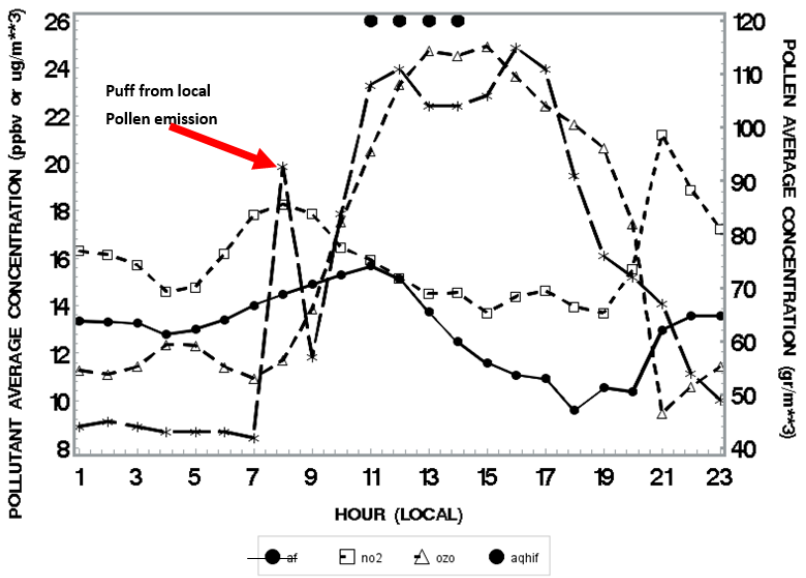
Figure 6. Averaged diurnal variation of model birch pollen (grains/m 3 ) and classical pollutant concentration (May 2012). af: aerosol fine (ug/m 3 ); no2: Nitrogen dioxide (ug/m 3 ); ozo: near-surface ozone (ppb); aqhif: air quality health